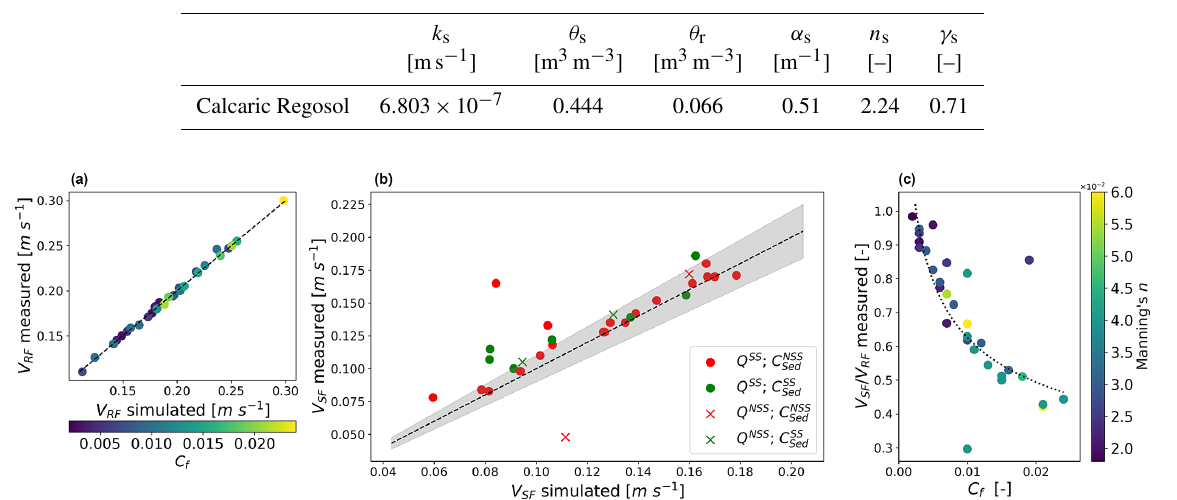
Table 3. Soil hydraulic parameters of Van Genuchten–Mualem model for simulated hillslopes, namely saturated hydraulic conductivity k s , saturated soil moisture θ s , residual soil moisture θ r , reciprocal air entry point α s , and soil hydraulic form parameters n s and γ s .